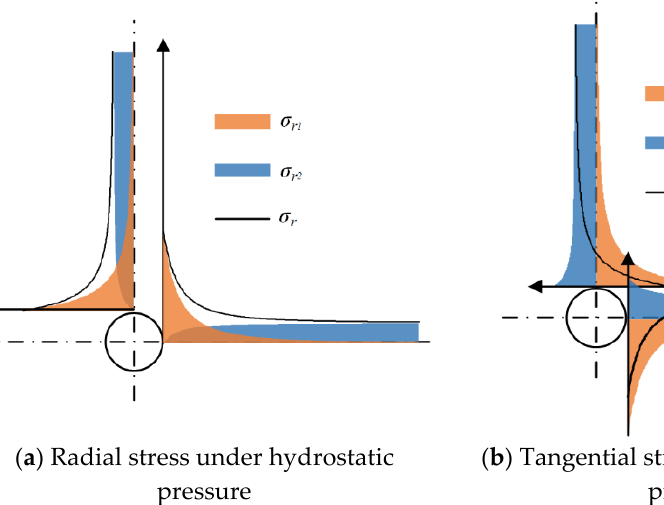
Figure 8. Stress characteristics around blasting holes.